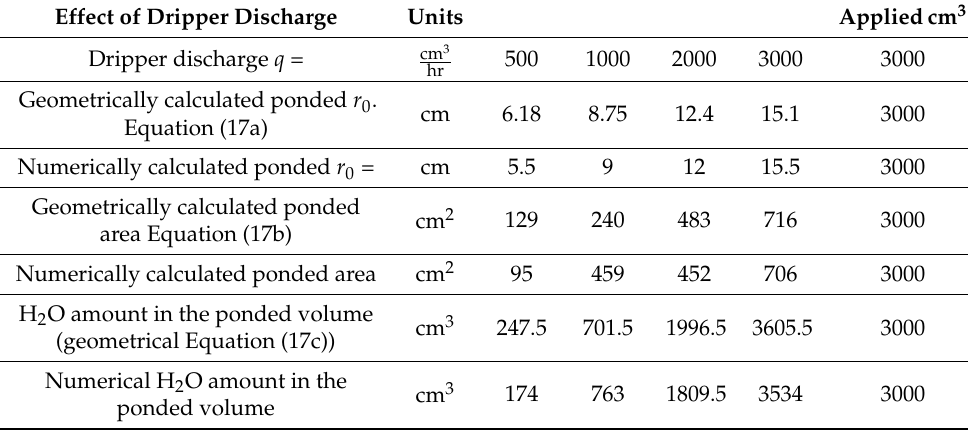
Table 3. Large-time radius of ponded surface under DI, its area and volume of water as a function of drippers discharge. In all cases the volume of water applied was 3000